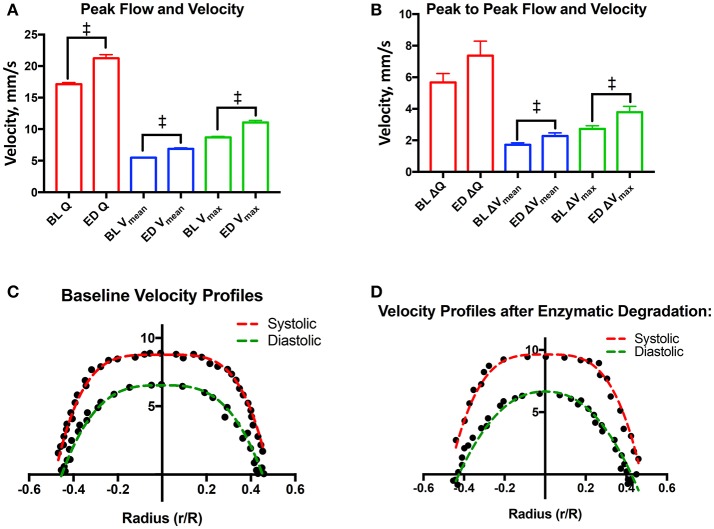
Velocity profiles after degradation of the EGL: (A) Systolic flow, mean velocity, and peak velocity after degradation of the glycocalyx (‡P < 0.05). (B) Changes in flow (Q), mean velocity (Vmean), and max peak velocity (Vmax) between systole and diastole after degradation of the glycocalyx (‡P < 0.05). (C) Baseline velocity profiles during systole and diastole. Results were fit to the model, υ(r)=Vmax(1-|rR|K). During systole, Vmax = 8.8 ± 0.2, R = 0.48 ± 0.01, and K = 4.1 ± 0.4. During diastole Vmax = 6.5 ± 0.4, R = 0.45 ± 0.01, and K = 3.1 ± 0.6. (D) Velocity profiles during systole and diastole after enzymatic degradation of the glycocalyx. Results were fit to the model, υ(r)=Vmax(1-|rR|K). During systole, Vmax = 9.6 ± 0.5, R = 0.47 ± 0.01, and K = 3.4 ± 0.7. During diastole Vmax = 6.7 ± 0.7, R = 0.43 ± 0.01, and K = 2.2 ± 0.6. (‡P < 0.05) compared to baseline.